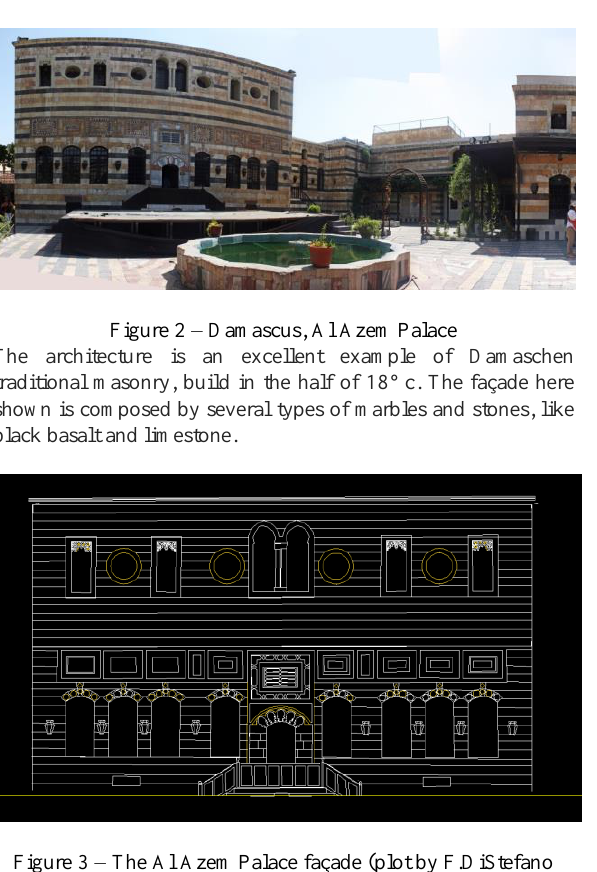
Figure 3 – The Al Azem Palace façade (plot by F.DiStefano produced with two spherical panoramas)